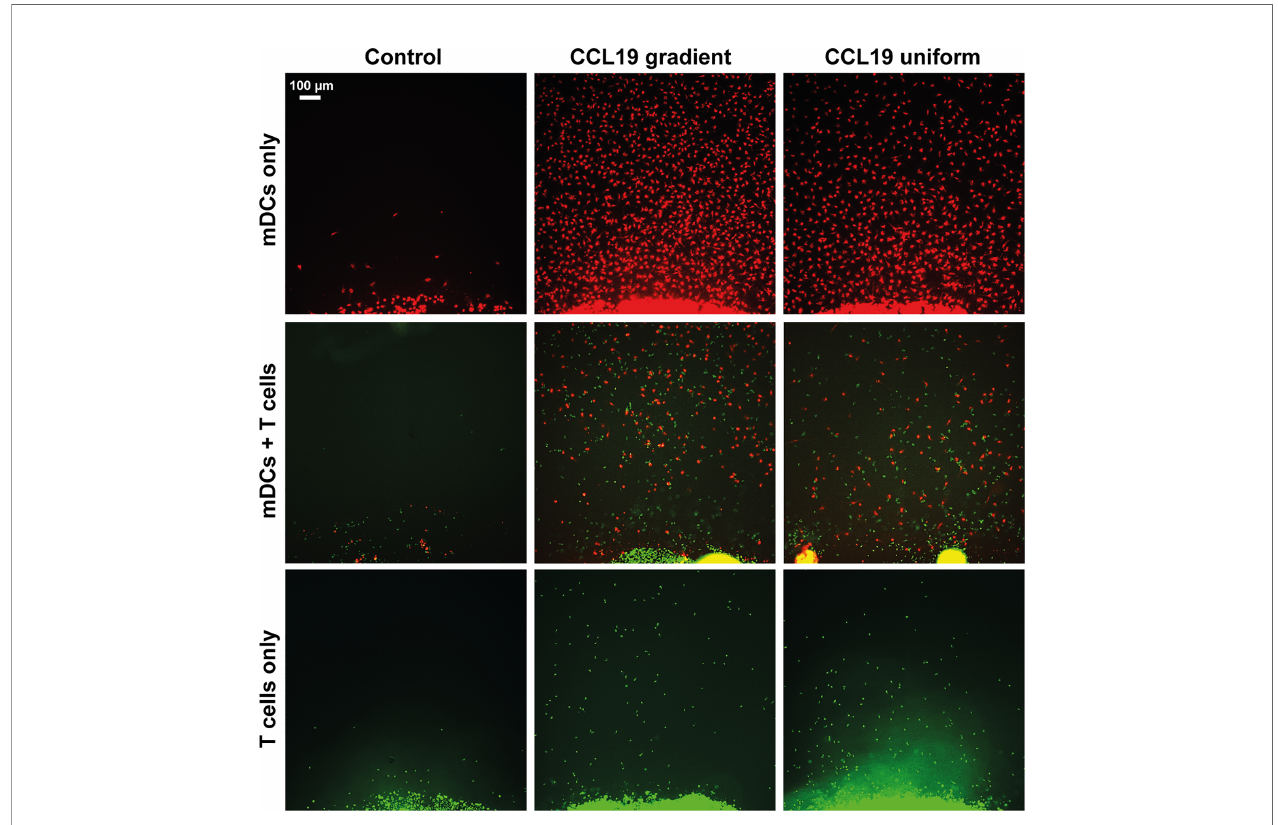
FIGURE 2 | Static assays do not clearly distinguish between chemotaxis and chemokinesis. Images showing migration after 16 hours of incubation of mDCs (red) and T cells (green) without chemokine (Control), in response to a CCL19 gradient, and 100 ng mL -1 uniform CCL19 concentration.